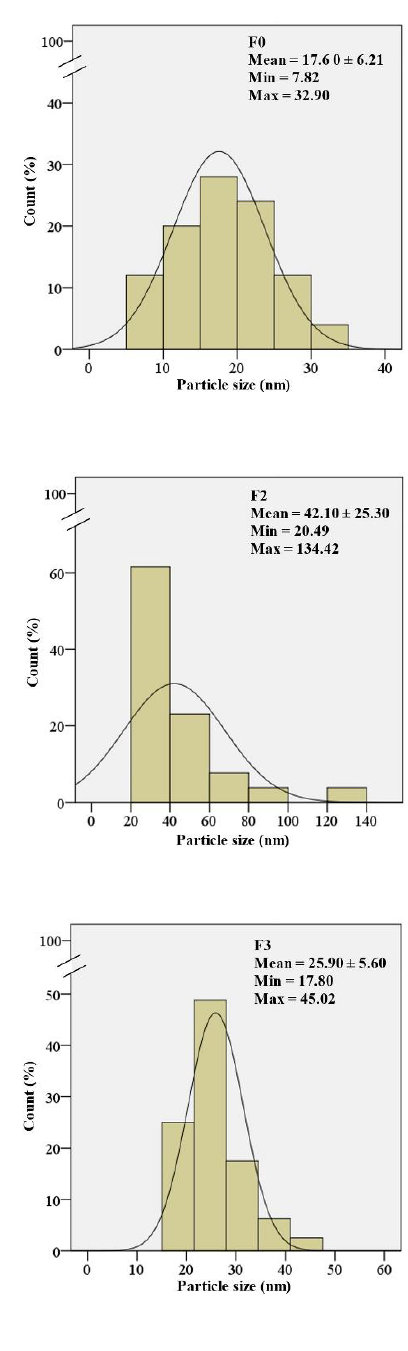
Figure 2. TEM micrograph and histogram of the particle size distribution of nanoparticles . ( A ) AgNPs in F0, and ( B – E ) Col - AgNPs in F2 – F5 . The electron microscope was operated at 200 kV, and the images were captured at the magnification of 40,000× . A scale bar of 200 nm was provided . The FT - IR spectra of F0 and F2 – F5 revealed the functional groups of SDS in the na- noparticles in which the SDS signals, including S = O stretching ( symmetric ) , S = O stretch- ing ( asymmetric ) , C - H stretching ( symmetric ) , and C - H stretching ( asymmetric ) were found at 1219 – 1223, 1467 – 1467, 2851 – 2853, and 2920 – 2922 cm −1 , respectively . ( Figure 3A ). In addition, the colistin signals in F2 – F5 consisted of C - N stretching, N - H bending ( amide II ) , C = O stretching ( amide I ) , and C - H stretching, which occurred at 1100 – 1105, 1542 – 1548,